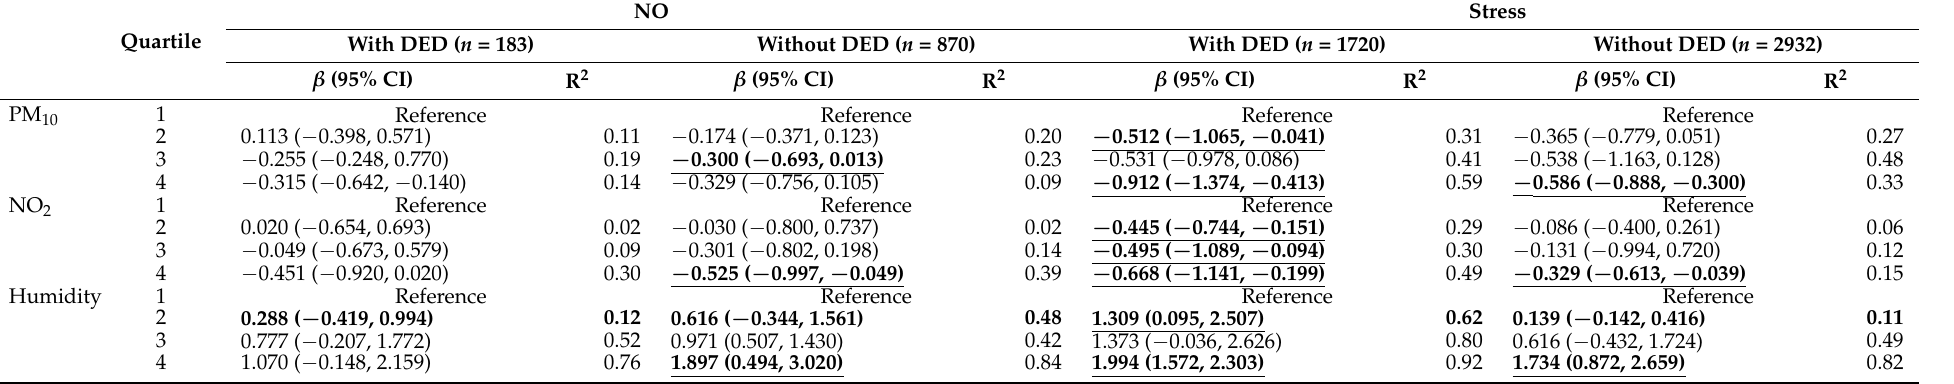
Values with p < 0.05 are indicated in bold, underlined text. R 2 : Coefficients of determination; adjusted for all the potential covariates in Table 4 including BMI, chronic diseases, allergies, smoking, drinking, eye surface status, education, income, business style, work intensity, and family pressure. Contrast with taxi drivers exposed to level 1 (PM 10 , NO 2 or humidity) to